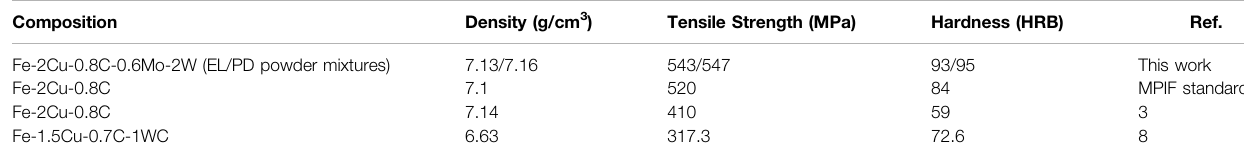
TABLE 2 | Properties comparison of sintered Fe-2Cu-0.8C-0.6Mo-2W materials. Composition Density (g/cm 3 )